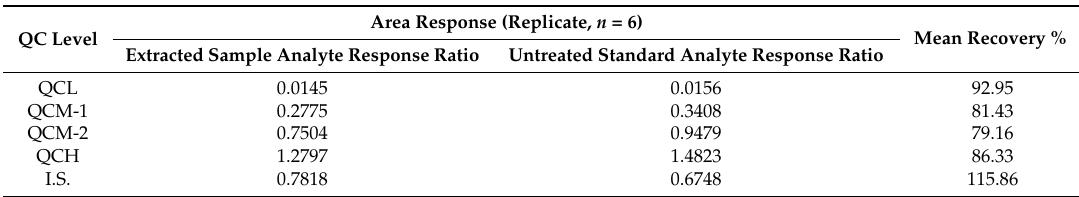
Table 4. Extraction recovery for folic